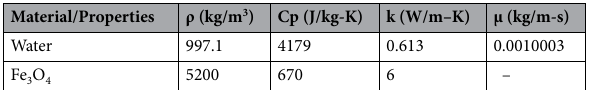
Table 1. Properties of base fluids and nanoparticles.